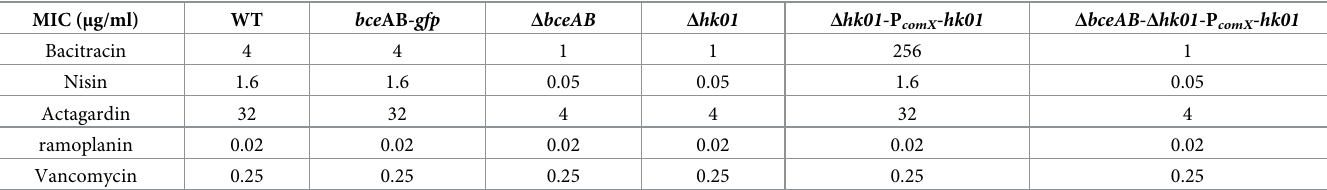
Table 3. Minimum Inhibitory Concentrations of several antimicrobial peptides against the R800 strains.